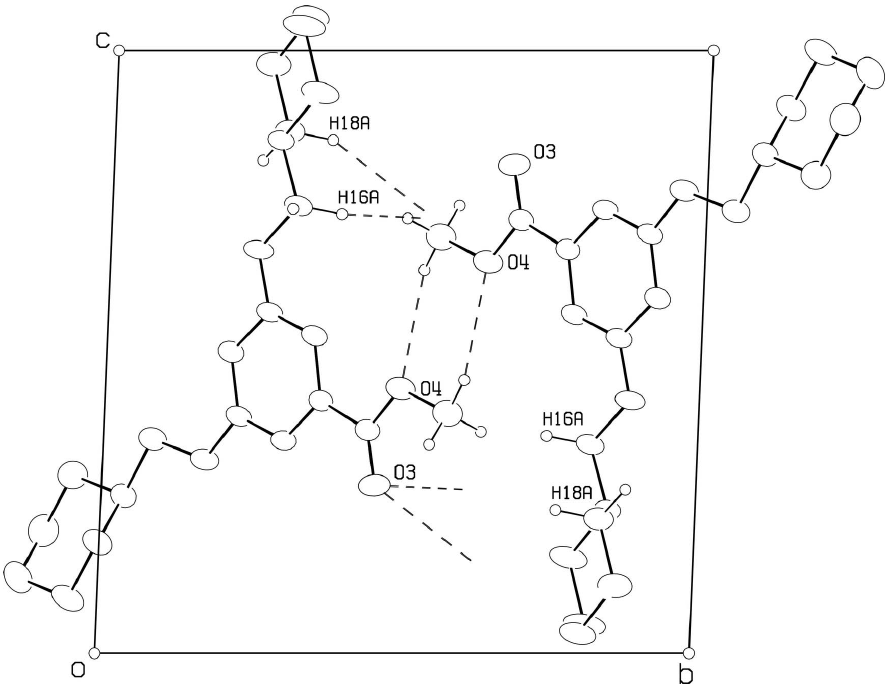
Figure 2 Packing of the title complex, viewed along the a * axis, with ellipsoid outlines at 30% probability. Proposed hydrogen bonds are shown as dashed lines. Hydrogen bonds from O3, C16A and C18A are to molecules translated by - a